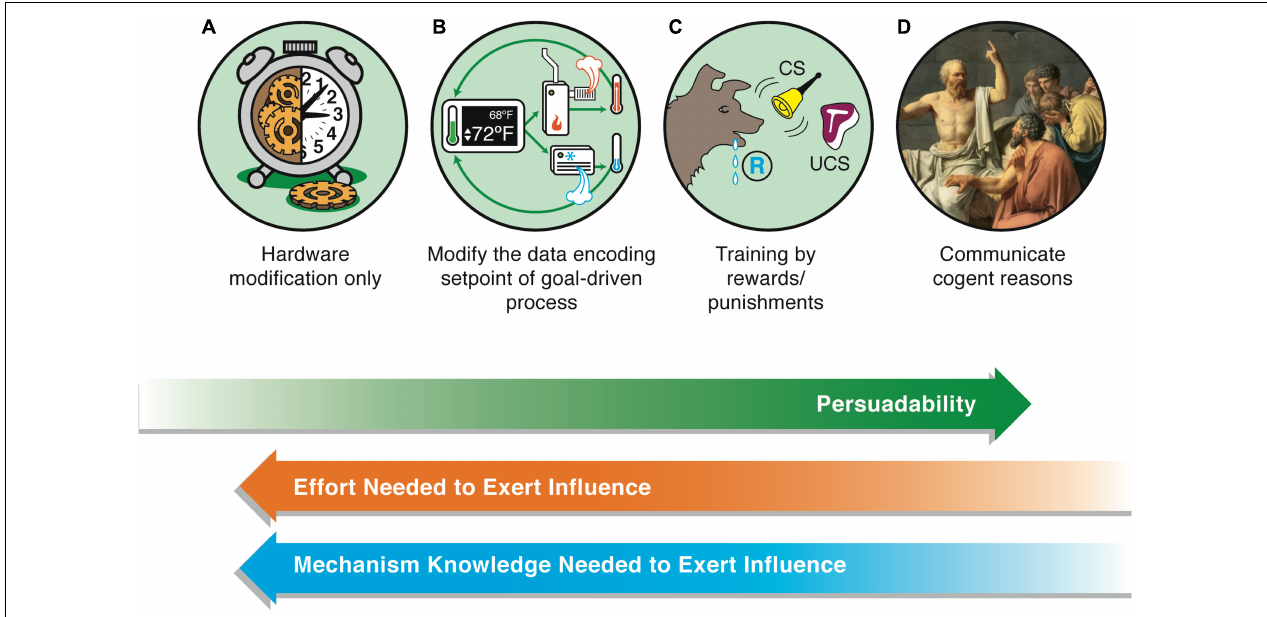
FIGURE 2 | The axis of persuadability. A proposed way to visualize a continuum of agency, which frames the problem in a way that is testable and drives empirical progress, is via an “axis of persuadability”: to what level of control (ranging from brute force micromanagement to persuasion by rational argument) is any given system amenable, given the sophistication of its cognitive apparatus? Here are shown only a few representative waypoints. On the far left are the simplest physical systems, e.g., mechanical clocks (A) . These cannot be persuaded, argued with, or even rewarded/punished—only physical hardware-level “rewiring” is possible if one wants to change their behavior. On the far right (D) are human beings (and perhaps others to be discovered) whose behavior can be radically changed by a communication that encodes a rational argument that changes the motivation, planning, values, and commitment of the agent receiving this. Between these extremes lies a rich panoply of intermediate agents, such as simple homeostatic circuits (B) which have setpoints encoding goal states, and more complex systems such as animals which can be controlled by signals, stimuli, training, etc., (C) . They can have some degree of plasticity, memory (change of future behavior caused by past events), various types of simple or complex learning, anticipation/prediction, etc. Modern “machines” are increasingly occupying right-ward positions on this continuum (Bongard and Levin, 2021). Some may have preferences, which avails the experimenter of the technique of rewards and punishments—a more sophisticated control method than rewiring, but not as sophisticated as persuasion (the latter requires the system to be a logical agent, able to comprehend and be moved by arguments, not merely triggered by signals). Examples of transitions include turning the sensors of state outward, to include others’ stress as part of one’s action policies, and eventually the meta-goal of committing to enhance one’s agency, intelligence, or compassion (increase the scope of goals one can pursue). A more negative example is becoming sophisticated enough to be susceptible to a “thought that breaks the thinker” (e.g., existential or skeptical arguments that can make one depressed or even suicidal, Gödel paradoxes, etc.)—massive changes can be made in those systems by a very low-energy signal because it is treated as information in the context of a complex host computational machinery. These agents exhibit a degree of multi-scale plasticity that enables informational input to make strong changes in the structure of the cognitive system itself. The positive flip side of this vulnerability is that it avails those kinds of minds with a long term version of free will: the ability through practice and repeated effort to change their own thinking patterns, responses to stimuli, and functional cognition. This continuum is not meant to be a linear scala naturae that aligns with any kind of “direction” of evolutionary progress—evolution is free to move in any direction in this option space of cognitive capacity; instead, this scheme provides a way to formalize (for a pragmatic, engineering approach) the major transitions in cognitive capacity that can be exploited for increased insight and control. The goal of the scientist is to find the optimal position for a given system. Too far to the right, and one ends up attributing hopes and dreams to thermostats or simple AIs in a way that does not advance prediction and control. Too far to the left, and one loses the benefits of top-down control in favor of intractable micromanagement. Note also that this forms a continuum with respect to how much knowledge one has to have about the system’s details in order to manipulate its function: for systems in class A, one has to know a lot about their workings to modify them. For class B, one has to know how to read-write the setpoint information, but does not need to know anything about how the system will implement those goals. For class C, one doesn’t have to know how the system modifies its goal encodings in light of experience, because the system does all of this on its own—one only has to provide rewards and punishments. Images by Jeremy Guay of Peregrine